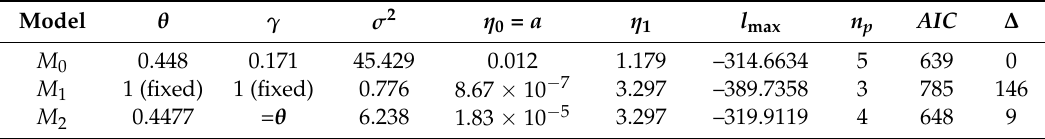
Table 4 . LED application: parameter estimates for three candidate models with deterministic drift coefficients ( b = 0).